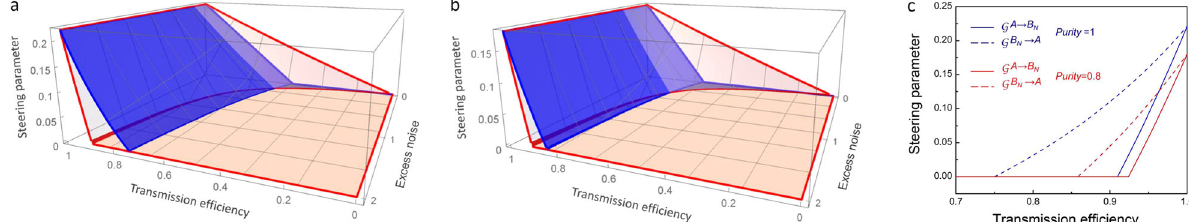
Fig. 4 Results for the effect of purity of the TMSS on EPR steering in a noisy channel. a , b The dependence of Gaussian EPR steering on transmission ef fi ciency and excess noise with initial pure and impure (purity is 0.8) TMSS, respectively. The steerabilities of G A ! B N and G B N ! A are given by the light red and blue colors, respectively. c The effect of noise on EPR steering of the TMSS with purities of 1 (blue curves) and 0.8 (red curves), respectively. The excess noise is taken as two times of vacuum noise.